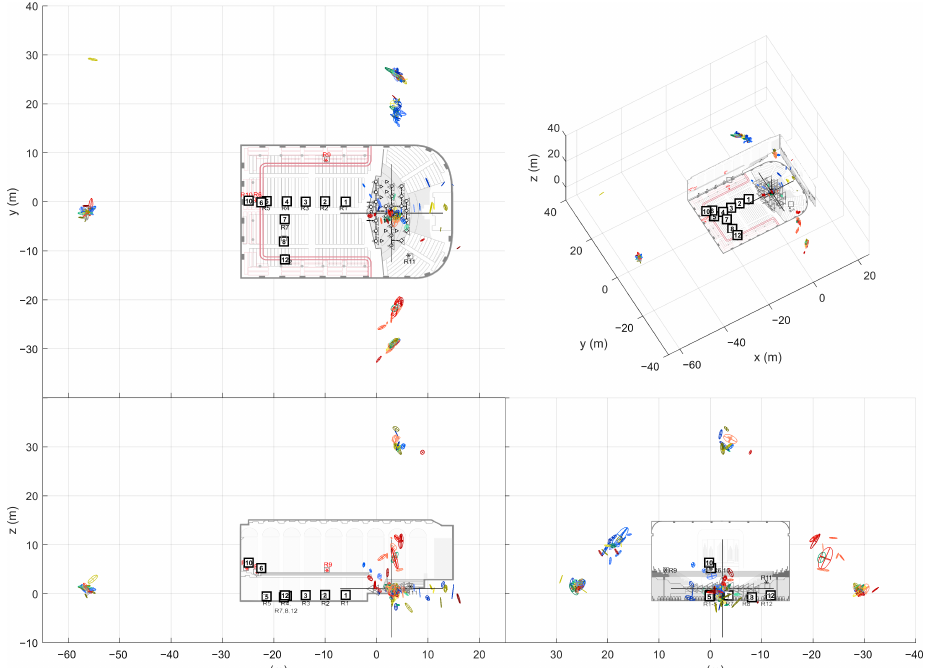
Figure A6. Centered source plot for Amsterdam Concertgebouw (min. 3 ER objects per image